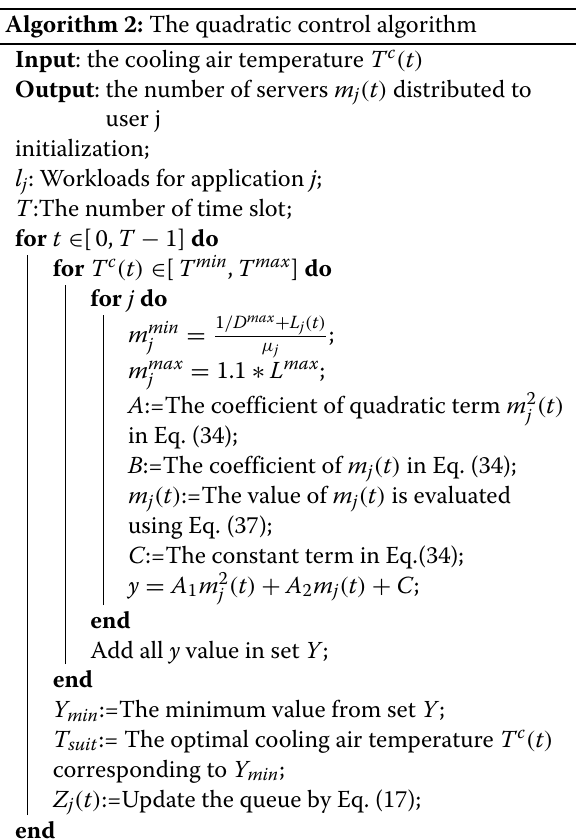
Algorithm 2: The quadratic control